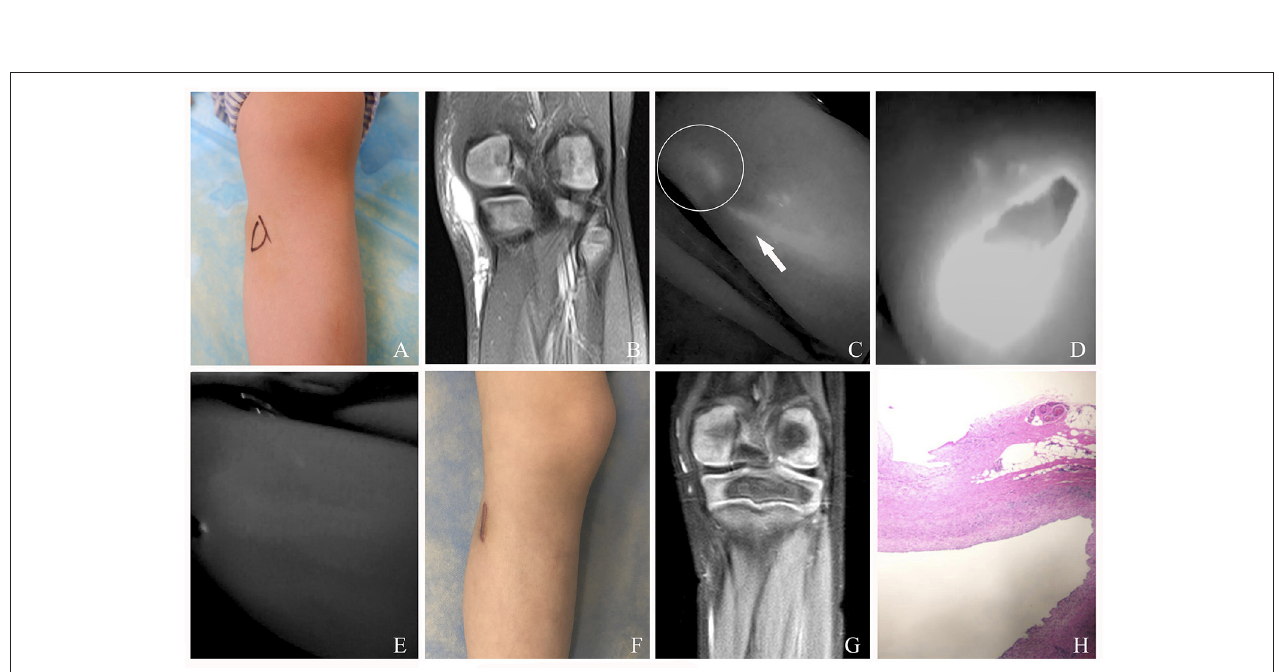
FIGURE 4 | (A) A 5-year-old female patient with mixed cLM of left knee preoperatively. (B) MRI preoperatively. (C) ICG finding with one afferent lymph vessel draining into a lesion. (D) The cLM lesion confirmed by ICG lymphography during surgery. (E) No inflow visualization or lymphatic leak on the previous detected site after inflow occlusion. (F) Twelve months postoperatively, complete regression of cLM met the criterion of excellent curative effect. Remarkably, this patient suffered from skin scar hyperplasia. (G) MRI postoperatively. (H) Pathology postoperatively. Arrow head , lymph vessel; circle , region of cLM.